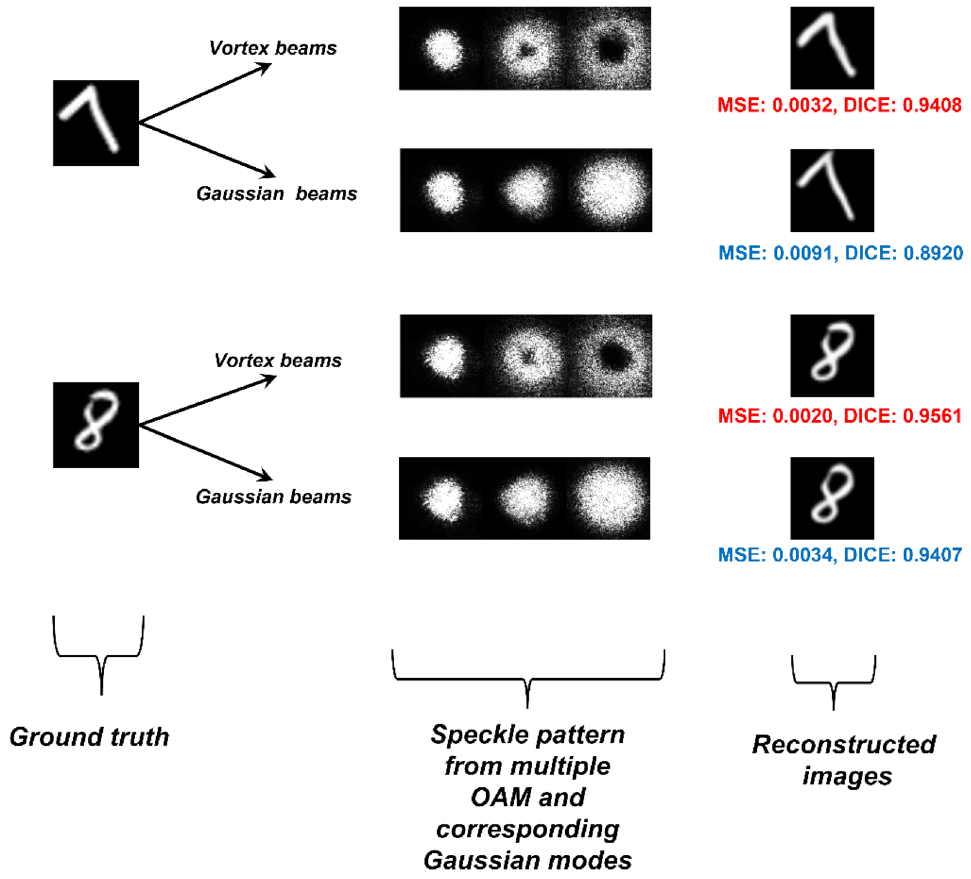
images is due to the difference in the colorbar and exposure settings of the beam